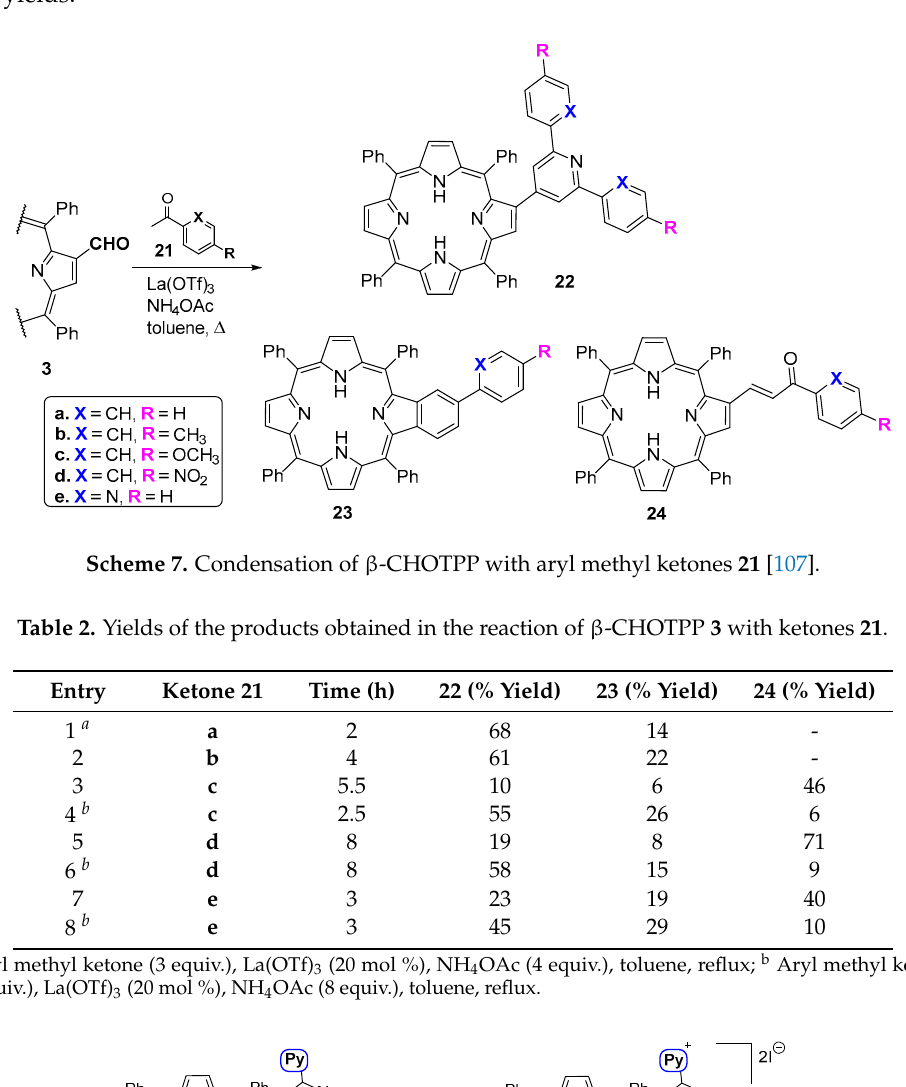
Figure 8. Structures of α , β -unsaturated derivatives obtained from the condensation of β -CHOTPP 3 with the adequate ketones [105,106].